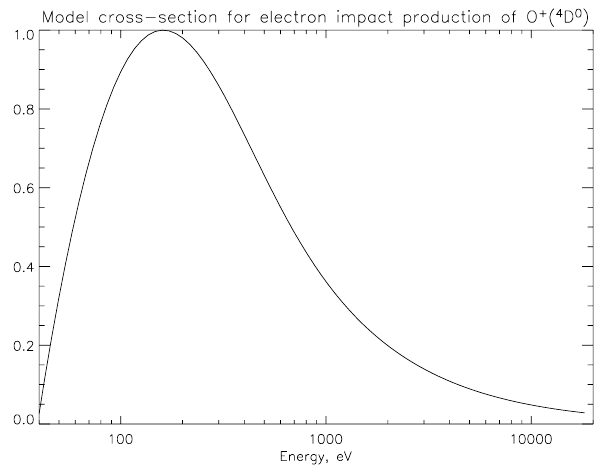
Fig. 14. Height-integrated emission rate of N + 1N(0,2) band (blue 2 curve) and O + multiplet vs. the energy of monoenergetic electron precipitation. Green curve shows the intensity due to the dissocia- tive ionisation, red curve shows the intensity due to the direct ion- isation of O (using the cross section estimated in this work). The dotted line is the total O + multiplet